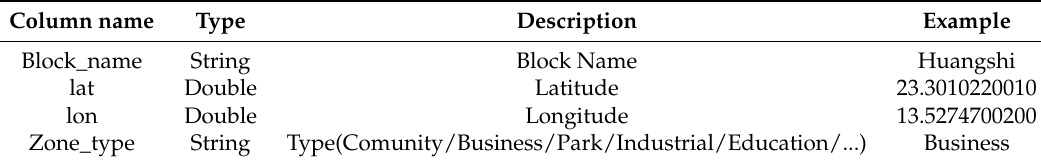
Table B3. District functions in